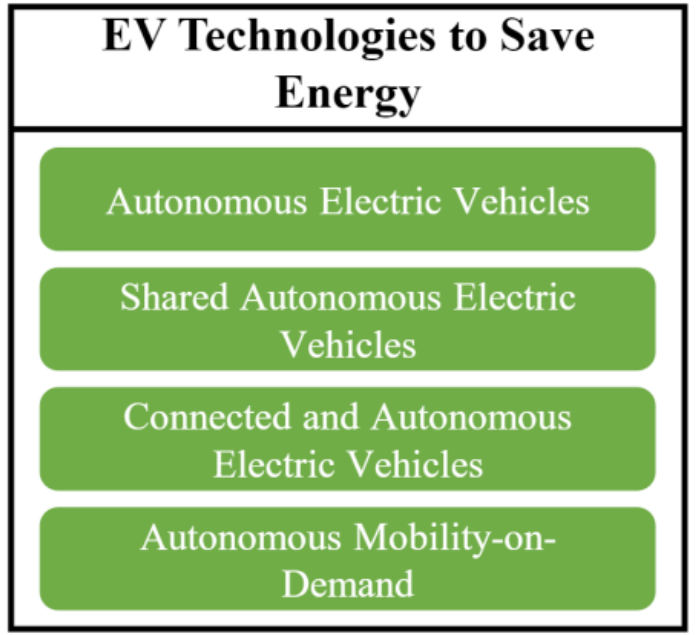
Figure 8. Different EV technologies to save energy.